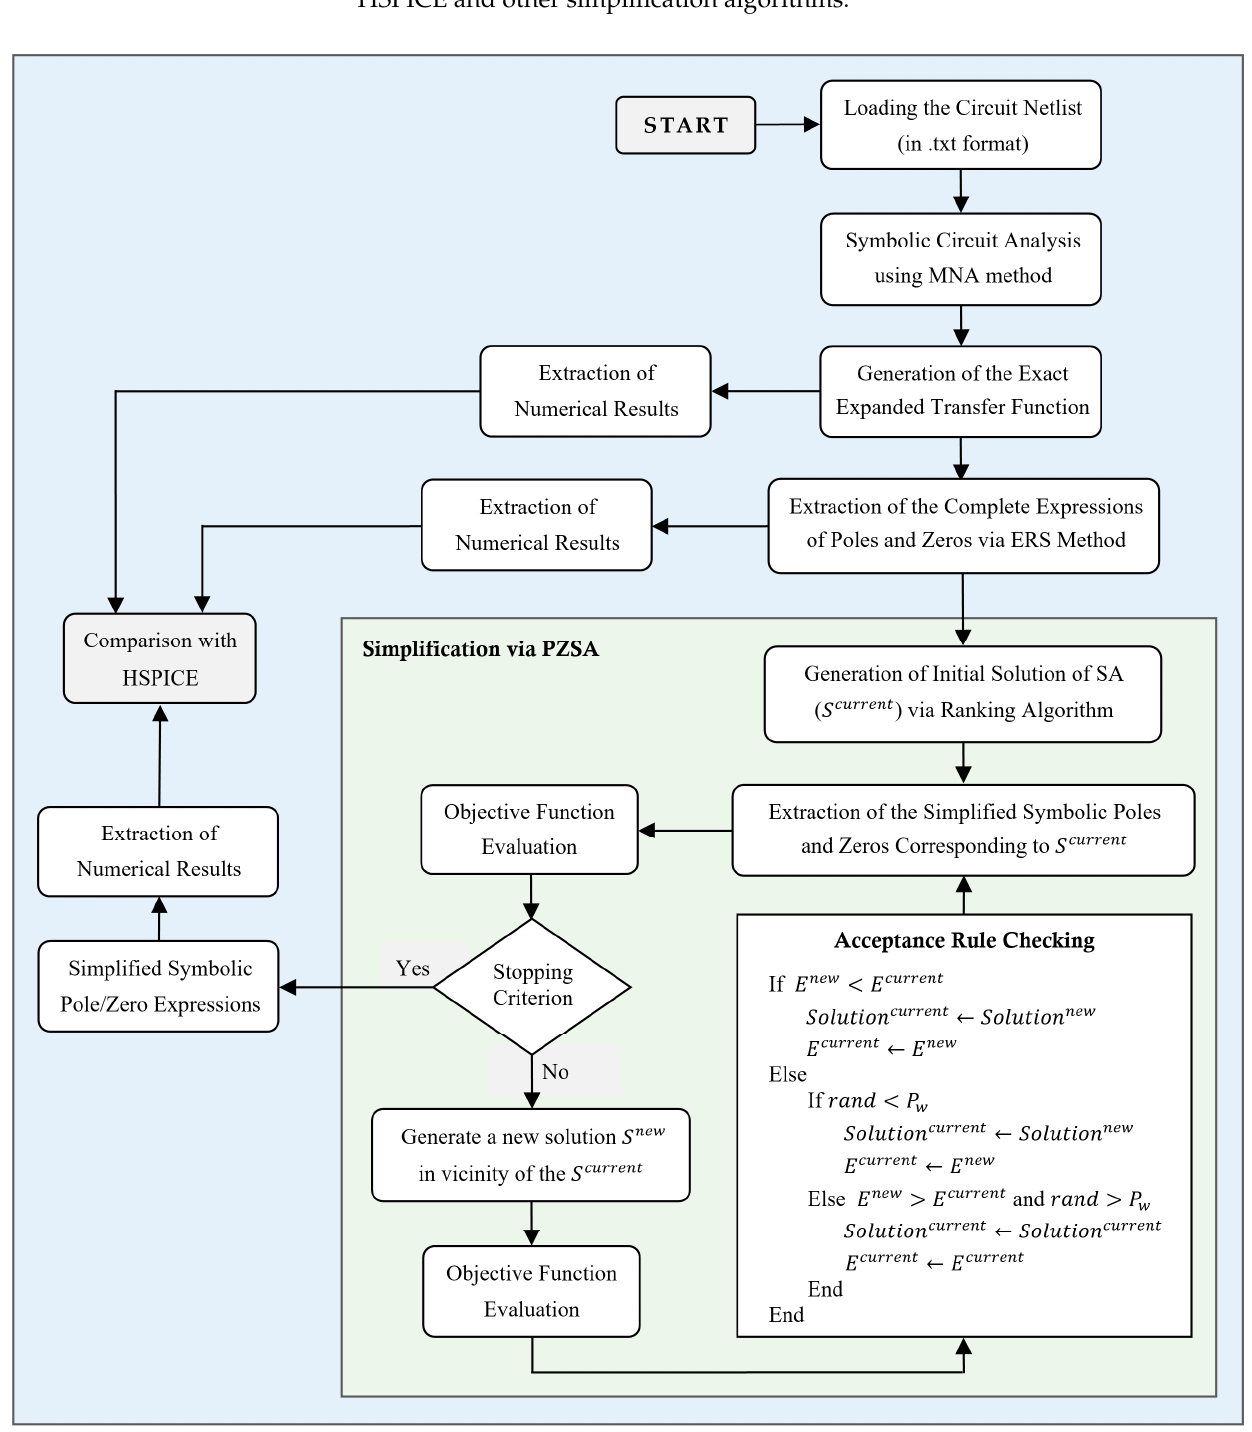
Figure 1. Overall fl owchart of the proposed methodology.